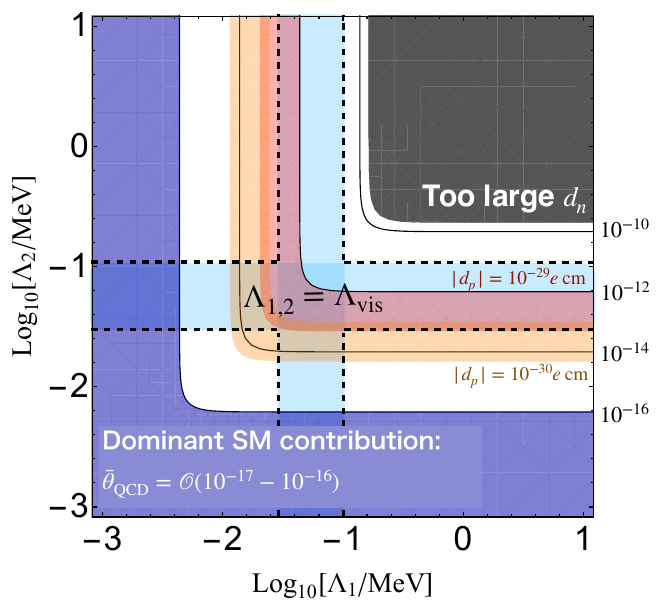
Figure 1 . Contour plot of strong CP phase, ¯ θ QCD , in the two axion models varying the non- perturbative scales Λ 1 , and Λ 2 . We have fixed the other parameters as θ = c 1 = 1 , c 2 = 0 . 5 , c 3 = 2 . The light blue shaded region in the dashed line represents Λ 1 = Λ vis or/and Λ 2 = Λ vis